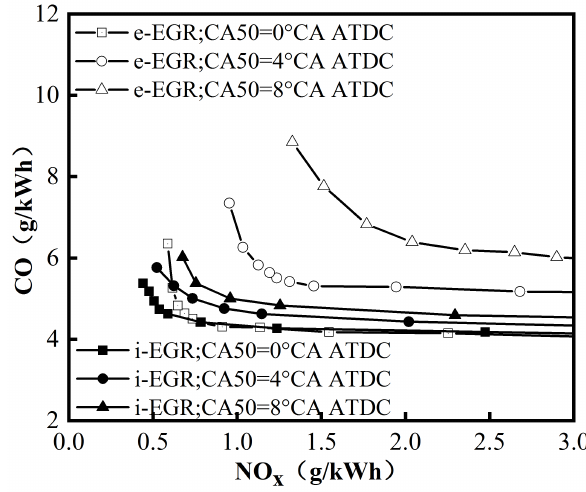
Fig. 11 Effects of CA50 and EGR ratio on CO